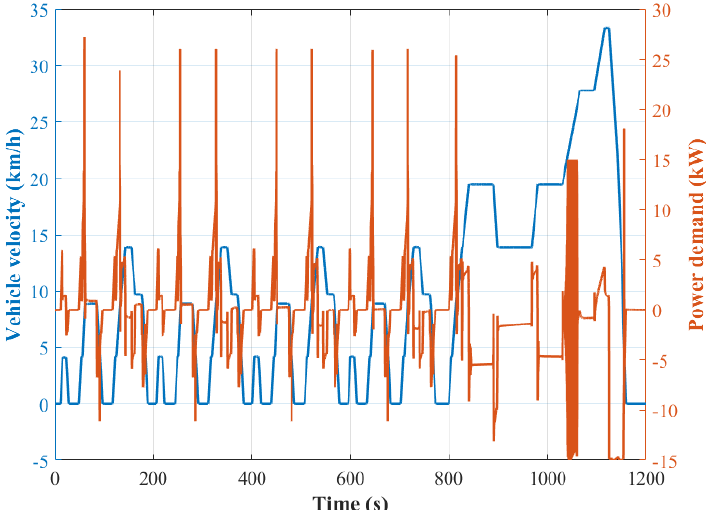
Figure 5. NEDC velocity and power demand curves.